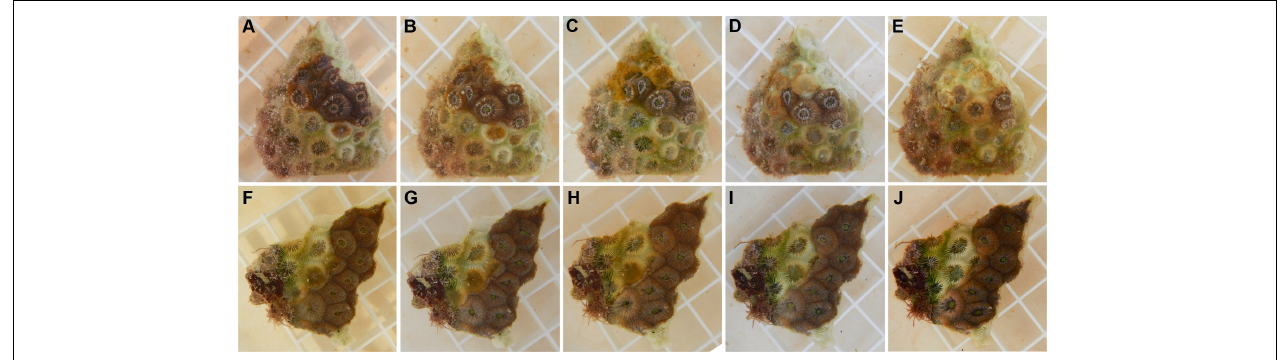
FIGURE 8 | Antibiotic treatment of diseased Montastraea cavernosa . (A) Through (E) photos of a control fragment without antibiotic treatment (A) before the start of the experiment, (B) after 24 h, (C) 48 h, (D) 72 h and (E) 96 h. (F) Through (J) photos of an antibiotic treated fragment (F) before treatment, (G) after 24 h, (H) 48 h, (I) 72 h, and (J) 96 h. Each square on the grid is 1 × 1